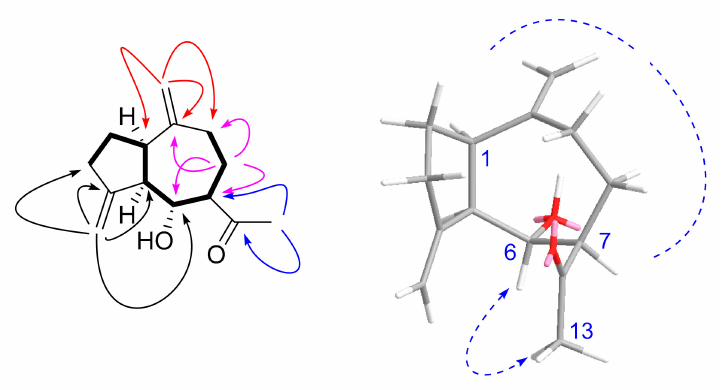
Figure 3. Key HMBC ( → ), 1 H- 1 H COSY ( ) and ROESY ( ↔ ) correlations for Compound 1.